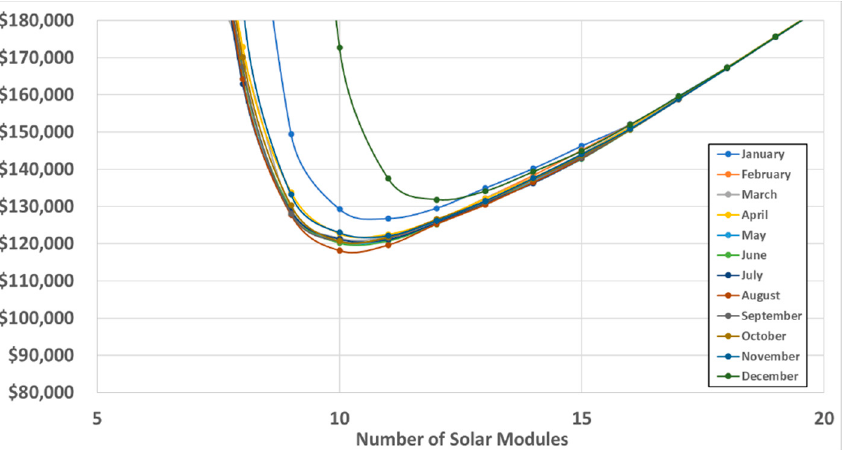
Figure 4. Variable starting month for IES given 10% initial charge, five systems, Indianapolis, and 0.1% Loss of Power Supply Probability (LPSP).